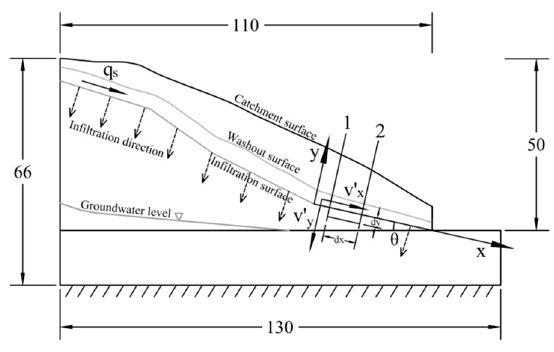
Figure 3. Three-dimensional model of the slope terrain.